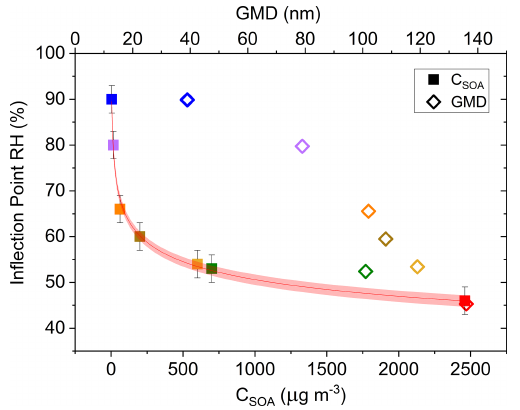
mass loading ( C SOA ; µgm − 3 ) ( (cid:4) ) and number geometric mean di- ameter (GMD; dry diameter; nm) ( ) of SOA distribution. Both C SOA and GMD observed immediately prior to start of humidifi- (cid:51) cation. Error bars represent ± 3%, and the red band indicates the 95% confidence band. Color scheme matches Fig.